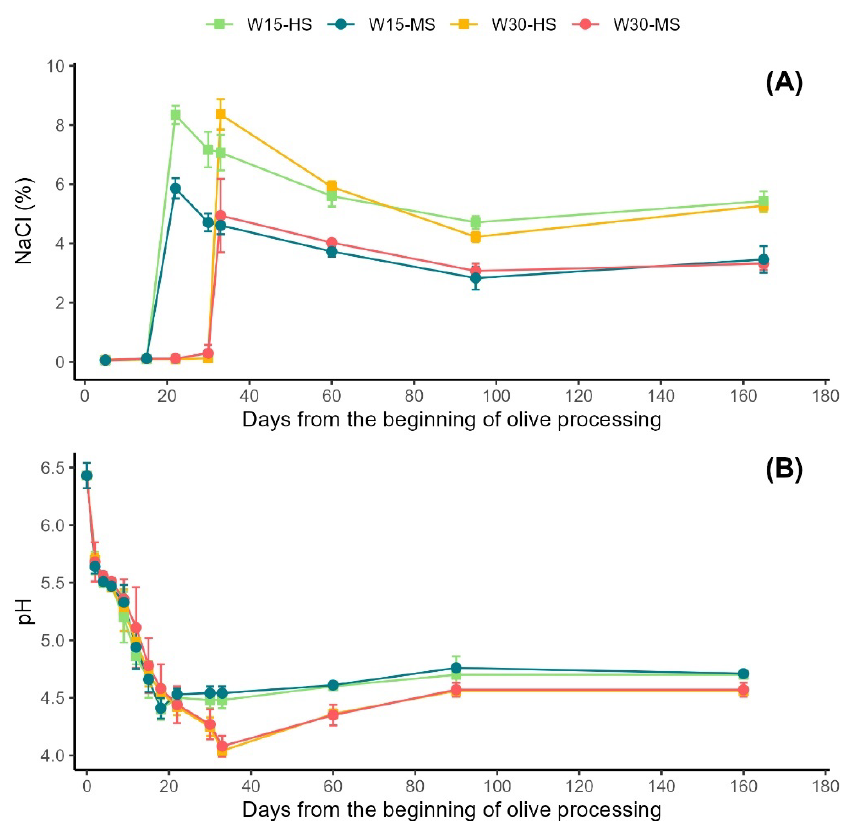
Figure 1. Evolution of ( A ) sodium chloride concentration and ( B ) pH of the brine during four processing methods. W15-HS: 15 days in water and then salting with 8% NaCl brine (pea); W15-MS: 15 days in water and then salting with 6% NaCl brine (teal); W30-HS: 30 days in water and then salting with 8% NaCl brine (orange); W30-MS: 30 days in water and then salting with 6% NaCl brine (crimson).